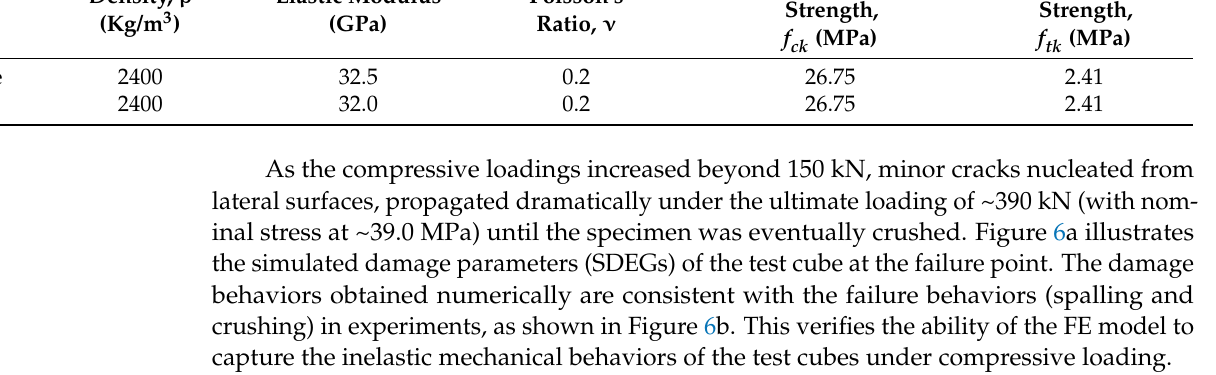
Figure 6. ( a ) Numerical and ( b ) experimental results of a crushed specimen.